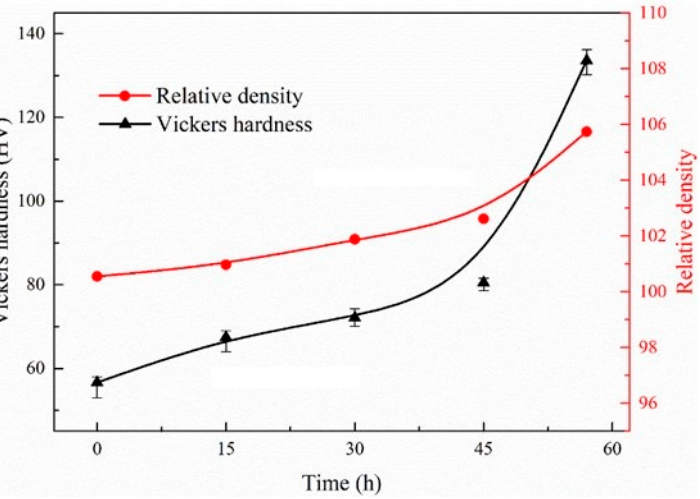
Figure 9. Effect of grinding time for magnesium powder on the hardness and relative density of CNTs/Mg composites.